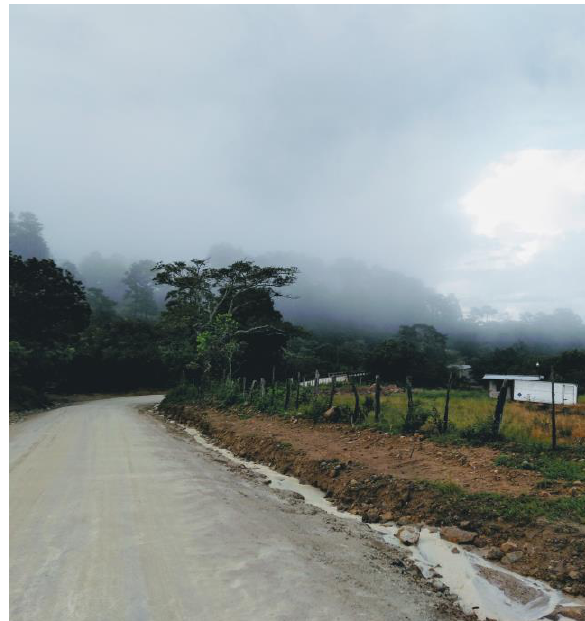
Figure 1. Dirt road between Gracias, San Manuel de Colohete and San Sebastian after a storm (October, 2019). Photograph: